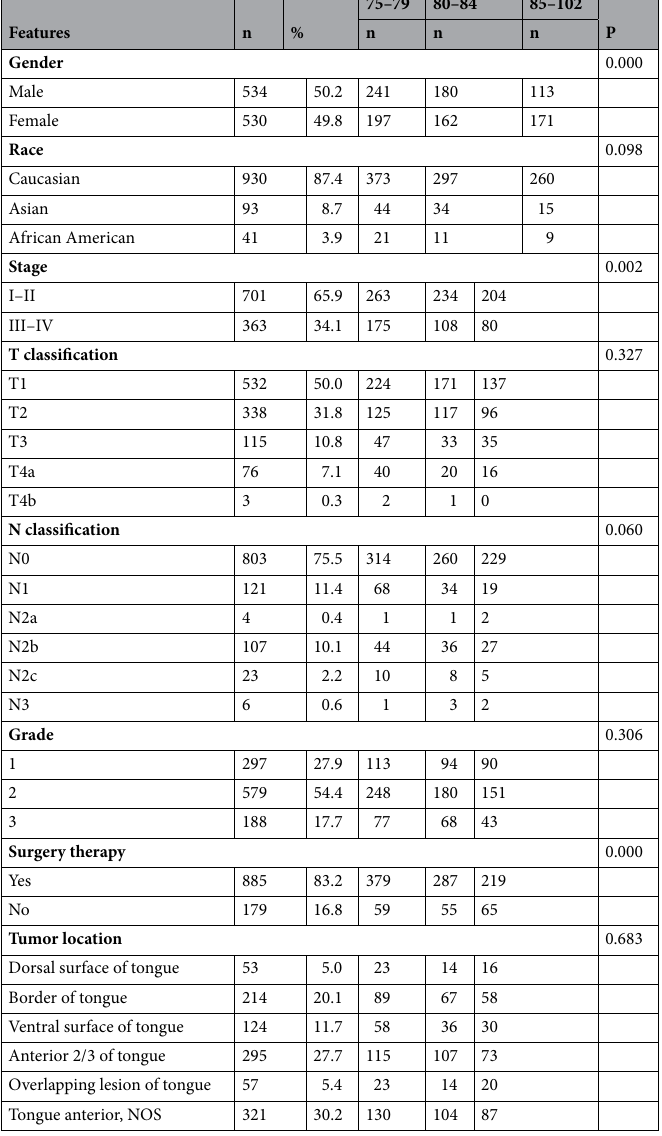
Table 1. Demographic features of patients stratified by age at diagnosis. NOS not otherwise